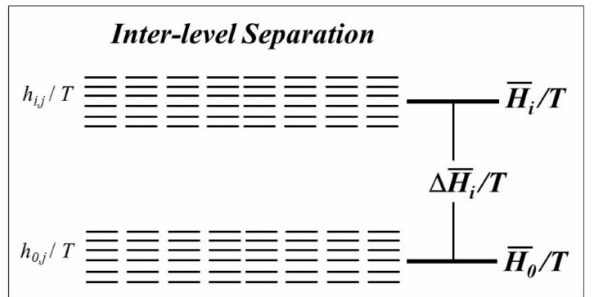
Figure 3. The distribution of molecules over sublevels h i , j of each macrolevel H i follows a statistical distribution: passage of molecules from population h 0 , j to population h i , j can be calculated by integration ( HEP